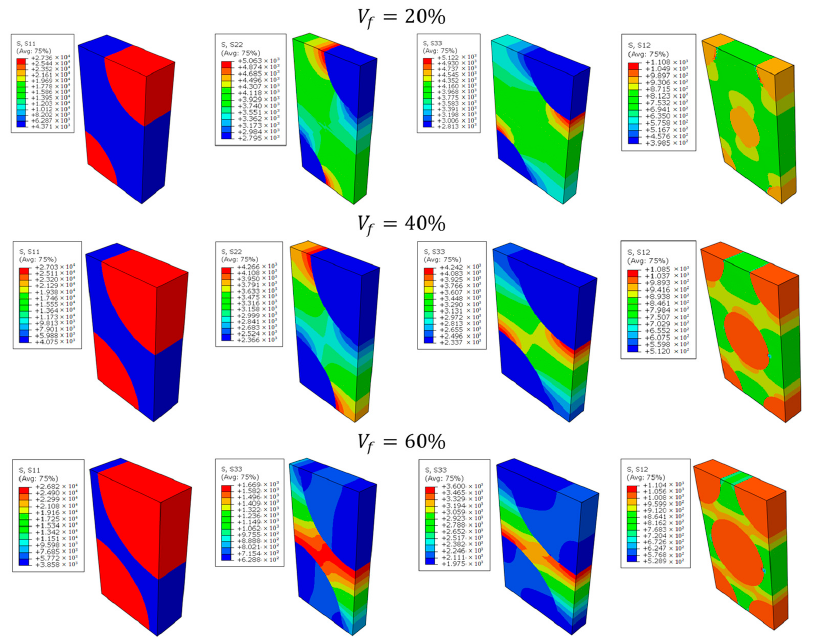
Figure 11. The stresses in RVE models with anisotropic fiber approach for different volume fractions (in MPa).